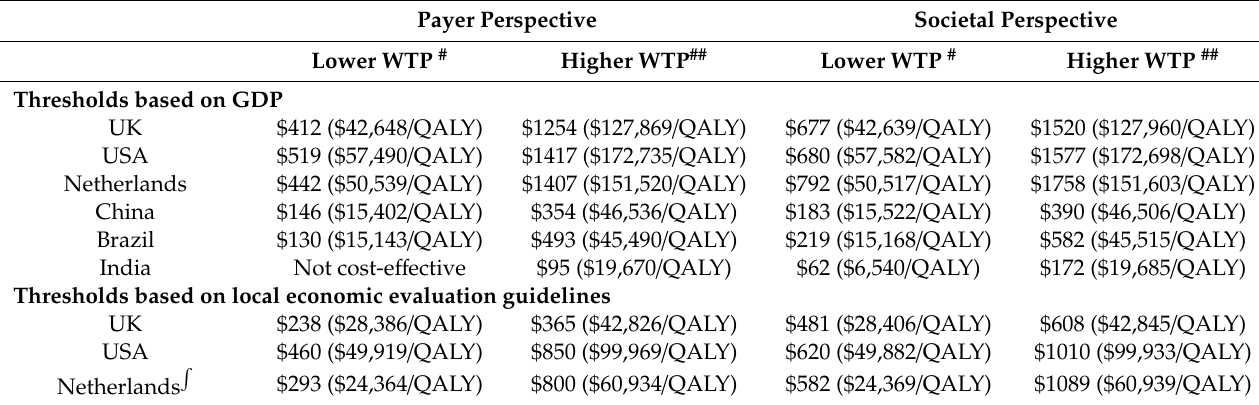
Table A5. Maximum values of genetic testing costs at which o ff ering genetic testing for the population remains cost-e ff ective.